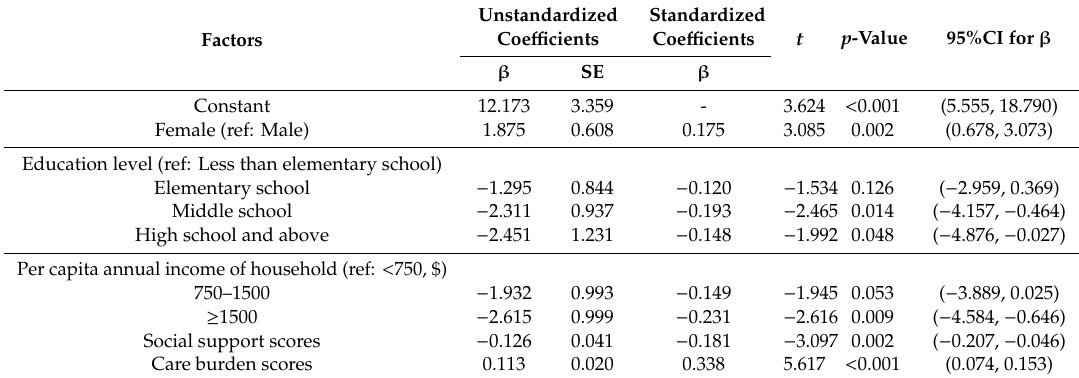
Table 4. Linear regression of factors associated with the